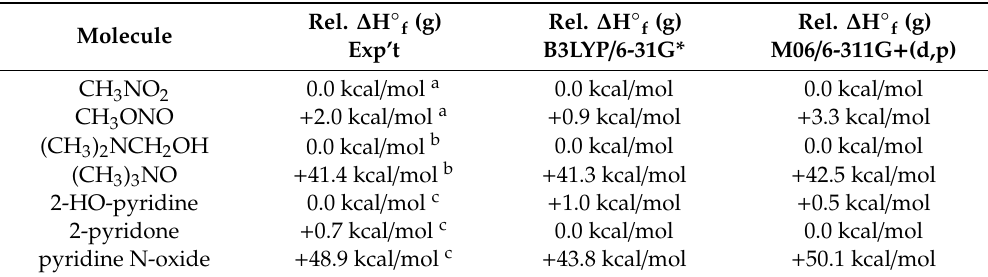
Table 1. Relative experimental and computational di ff erences in standard gas-phase enthalpies of formation for three sets of isomers relevant for the present study. In each column, for each set of isomers, the lowest ∆ H ◦ f (g) was set as 0.0 kcal / mol. Rel. ∆ H ◦ f (g) Rel. ∆ H ◦ f (g) Rel. ∆ H ◦ f (g) Molecule Exp’t B3LYP / 6-31G* M06 / 6-311G + (d,p) CH 3 NO 2 0.0 kcal / mol a 0.0 kcal / mol 0.0 kcal / mol CH 3 ONO + 2.0 kcal / mol a + 0.9 kcal / mol + 3.3 kcal / mol (CH 3 ) 2 NCH 2 OH 0.0 kcal / mol b 0.0 kcal / mol 0.0 kcal / mol (CH 3 ) 3 NO + 41.4 kcal / mol b + 41.3 kcal / mol + 42.5 kcal / mol 2-HO-pyridine 0.0 kcal / mol c + 1.0 kcal / mol + 0.5 kcal / mol 2-pyridone + 0.7 kcal / mol c 0.0 kcal / mol 0.0 kcal / mol pyridine N-oxide + 48.9 kcal / mol c + 43.8 kcal / mol + 50.1 kcal / mol = − 17.8 kcal / mol; ∆ H ◦ = − 15.8 kcal / mol) [19]. b Pedley: ∆ H ◦ a Pedley: ∆ H ◦ f ,g (CH 3 NO 2 ) f ,g (CH 3 ONO) f ,g